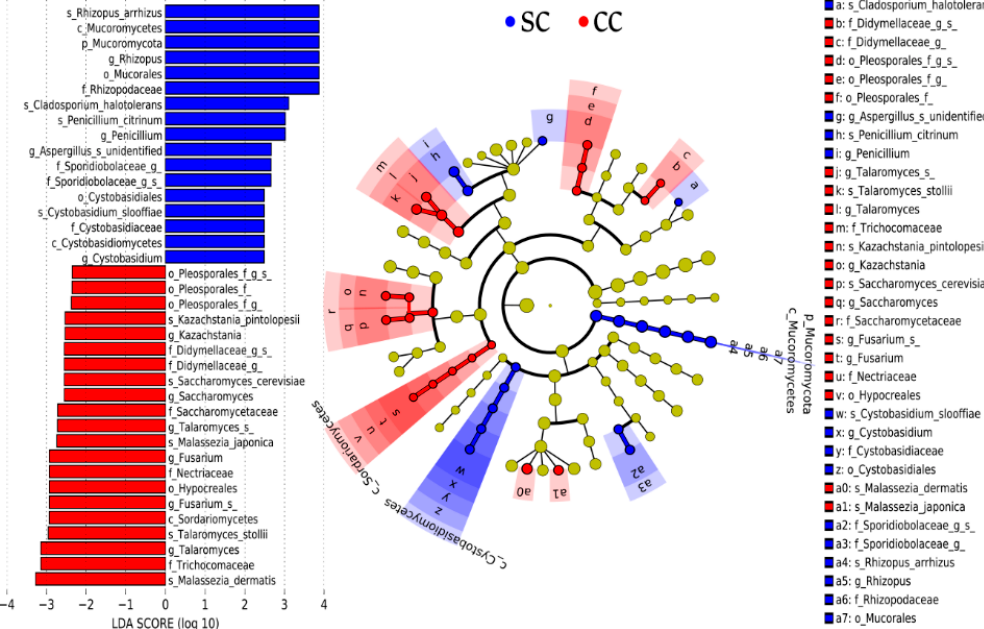
Figure 4. Identification of the main fungal taxa differentially represented in stool samples from SC and CC animals. The Core 70 OTU Table (see Methods) was subjected to a linear discriminant analysis effect size (LEfSe) analysis to identify differentially represented taxa between CC and SC animals. Taxa preferentially present in CC animals displayed Linear Discriminant Analysis (LDA) Scores ≤ 2, while taxa preferentially present in SC animals displayed LDA Scores ≥ 2. All taxa identified in this analysis display statistical significance at p ≤ 0.05, which was used as a threshold in the LEfSe analysis. All differentially represented taxa (at different taxonomic levels) are shown in the left panel of the figure and their distribution in a phylogenetic dendrogram is shown at the center panel. The concentric circles of the dendrogram show the taxonomic hierarchy, from phylum (innermost circle) to species (outermost circle) and the different microorganisms distributed in each node can be identified with the aid of the legend shown on the right panel. Microorganisms overrepresented in stool samples from SC animals are shown in blue, while microorganisms overrepresented in stool samples from CC animals are shown in red.